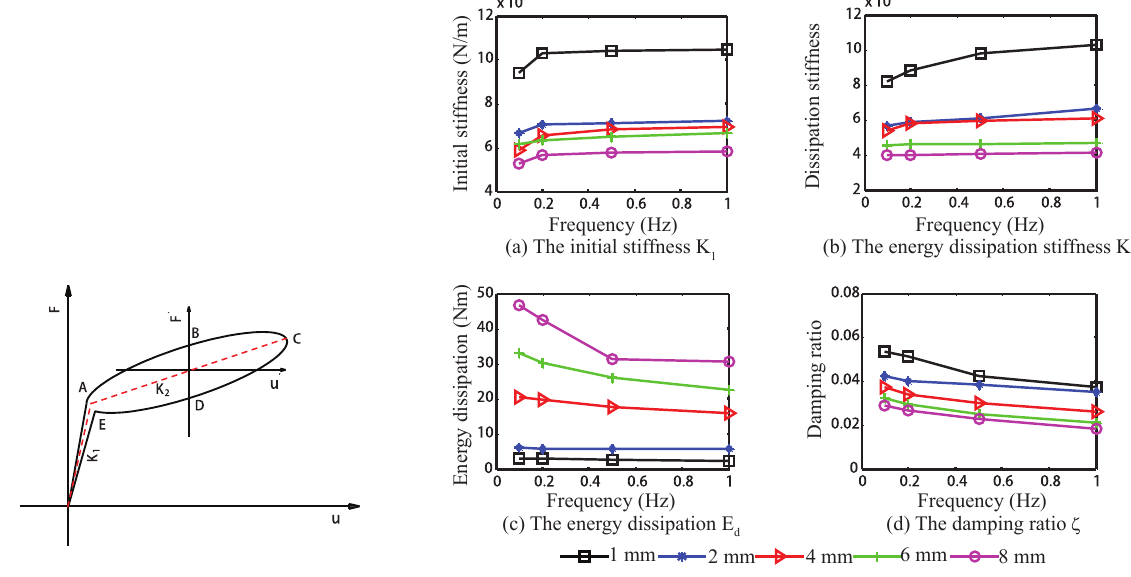
Fig. 8. Characteristics of the hysteresis curve of the device. Fig. 9. Frequency’s effect on characteristic parameters of the